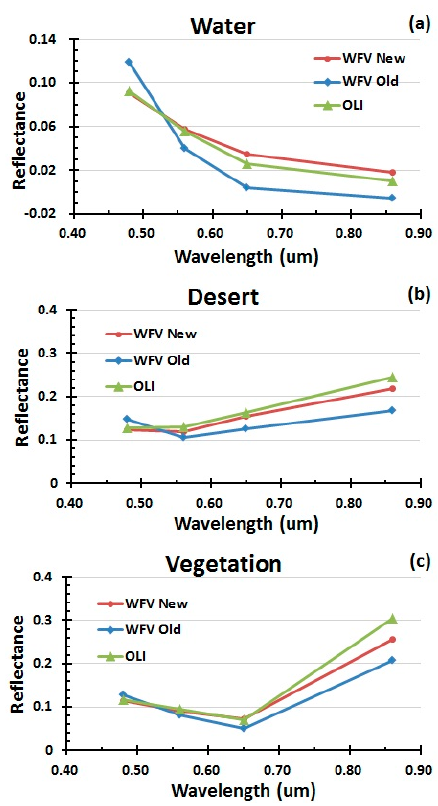
Figure 9. Comparison of the reflectance between Landsat 8 OLI and Gaofen-1 WFV under typical surface conditions: ( a ) water; ( b ) desert; and ( c ) vegetation. Both cross calibrated (new) and officially coefficients calibrated (old) WFV reflectance were plotted. The cross calibrated WFV agreed much better with the OLI reflectance.